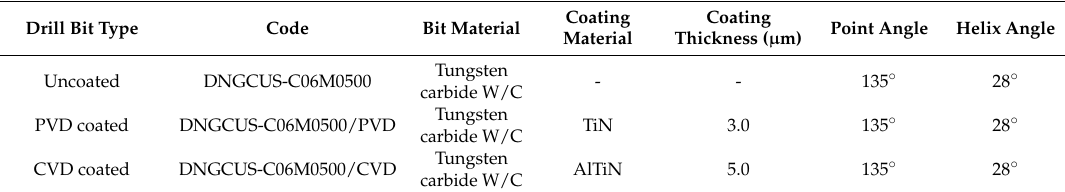
Table 1. Drill bits specifications.